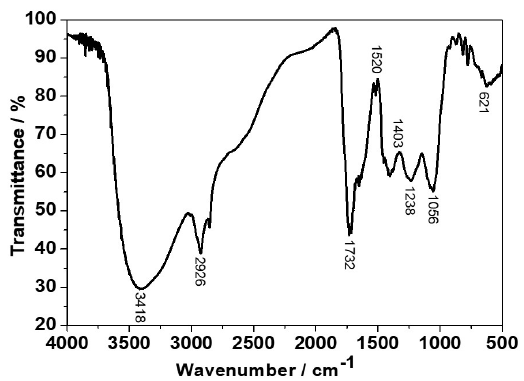
Figure 1. FTIR spectrum of CBP.